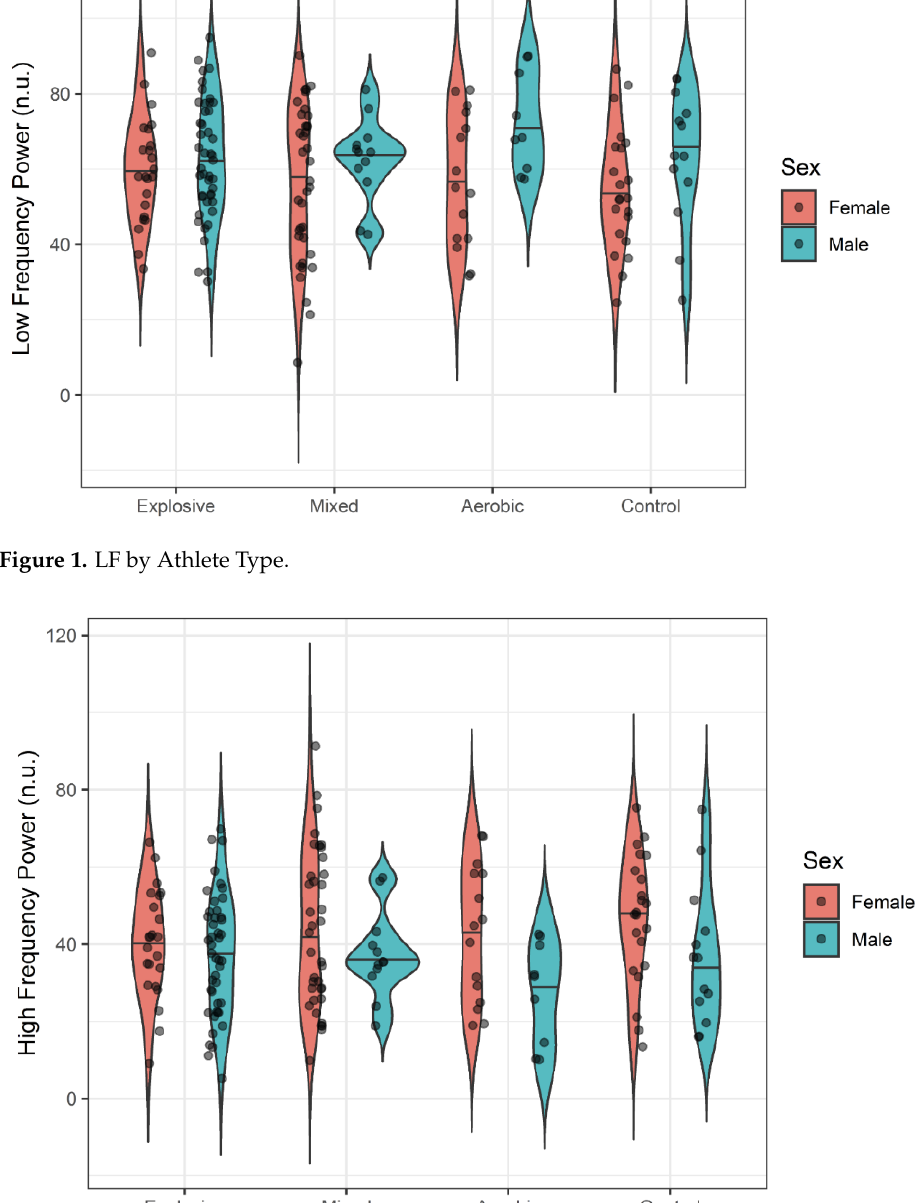
Figure 2. HF by Athlete Type.